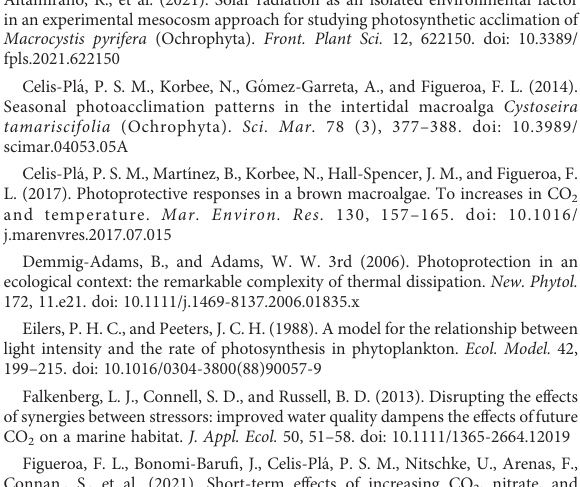
Figueroa, F. L., Bonomi-Baru fi , J., Celis-Pla ́ , P. S. M., Nitschke, U., Arenas, F., Connan., S., et al. (2021). Short-term effects of increasing CO 2 , nitrate, and temperature on photosynthetic activity in Ulva rigida (Chlorophyta) estimated